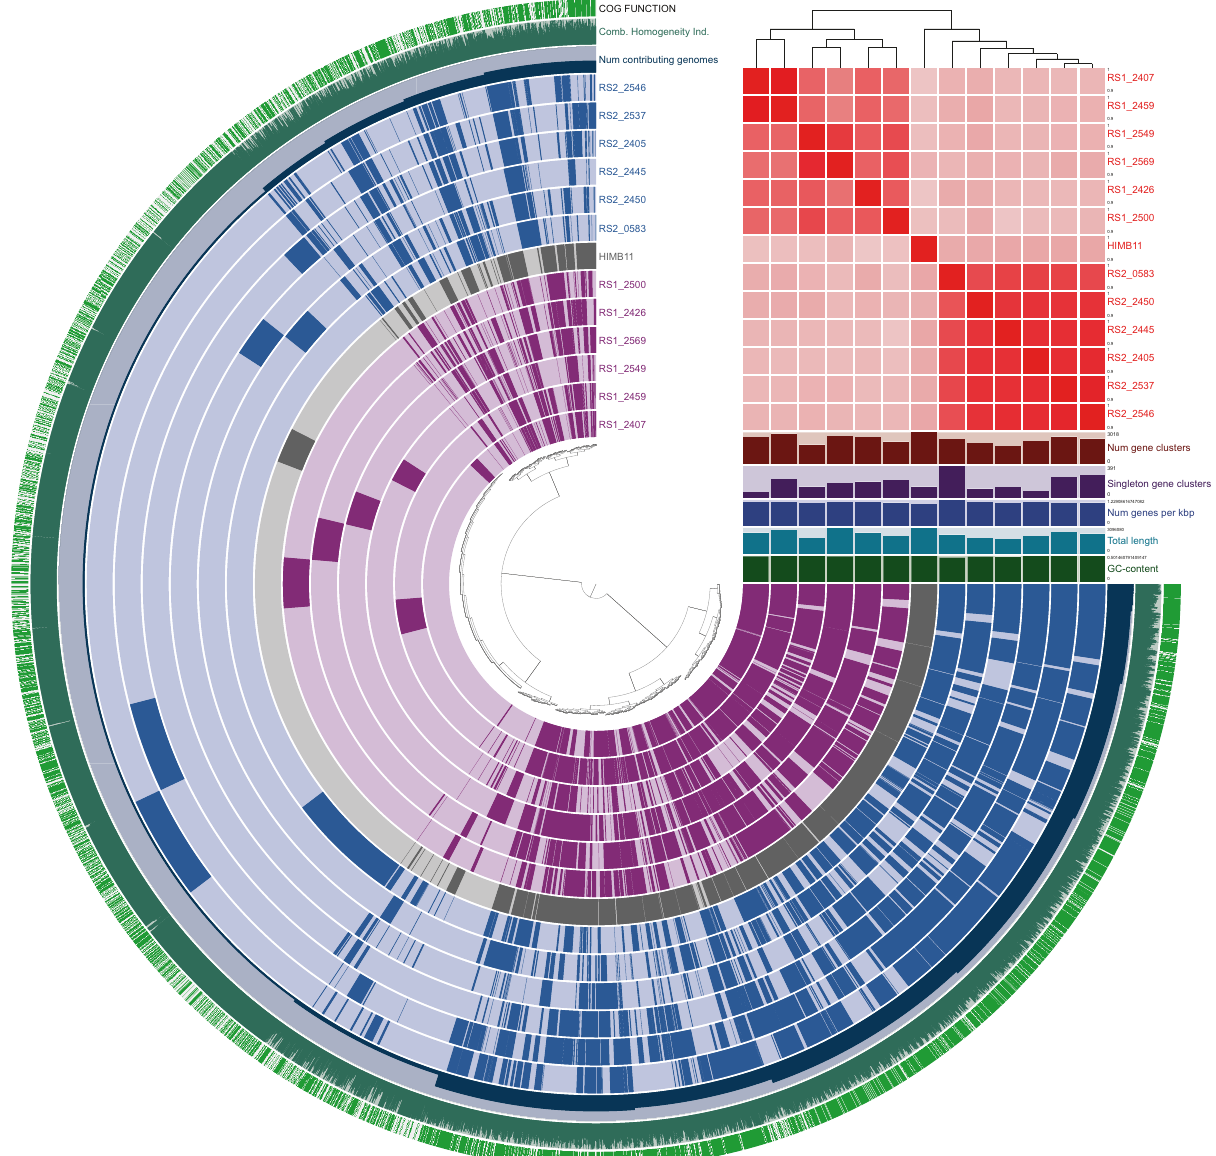
Fig. 4 Comparative genome analysis of Rhodobacter spp. SAGs obtained from the Red Sea seawater. Anvi ’ o representation of Rhodobacter spp., including six RS1 SAGs (Purple) and six RS2 SAGs (Navy Blue) recovered from seawater. HIMB11 (Gray), the reference genome, is the genome of known Rhodobacter sp. containing >99% identical 16S rRNA gene. The heat map in the upper right part shows the ANI values of RS1, RS2, and the reference genome, and the details are shown in Fig. S4. The fi gure shows the presence/absence of 6274 gene clusters in the pangenome of 12 SAGs and the reference genome. Inter-strain average nucleotide identity was <94%, and RS1-speci fi c or RS2-speci fi c gene clusters were